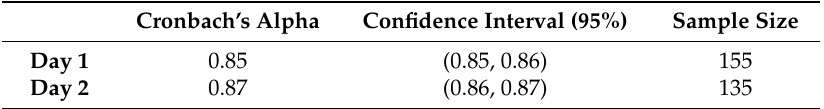
Table 6. Cronbach’s alpha coefficient of reliability (or consistency). This shows that the internal consistency of the NNA is high, indicating that it and its components provide a reliable diet score.